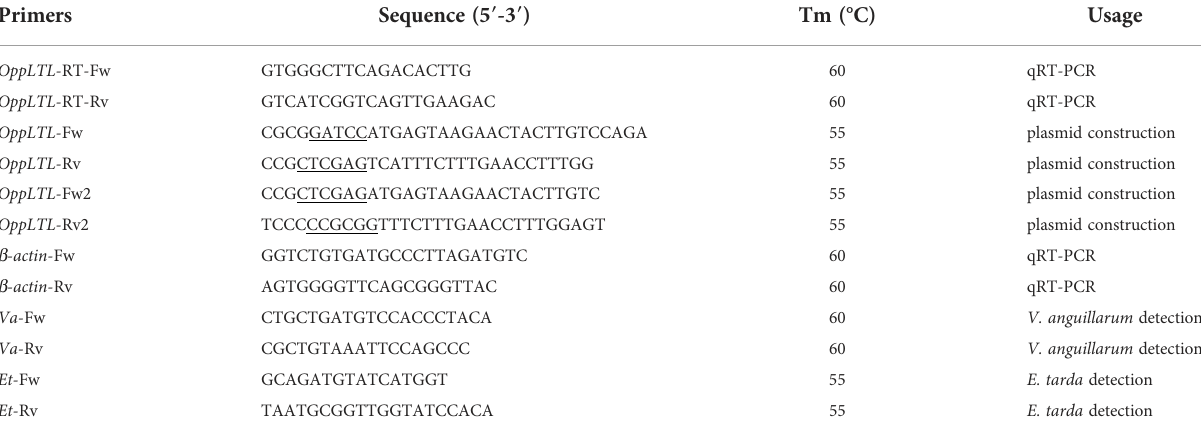
TABLE 1 List of the primer sequences used in the study.